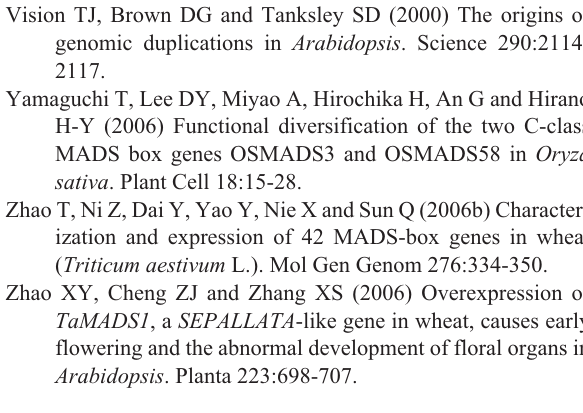
Figure S1 - Alignment of the intron IV sequence of the WAG-2 gene from different